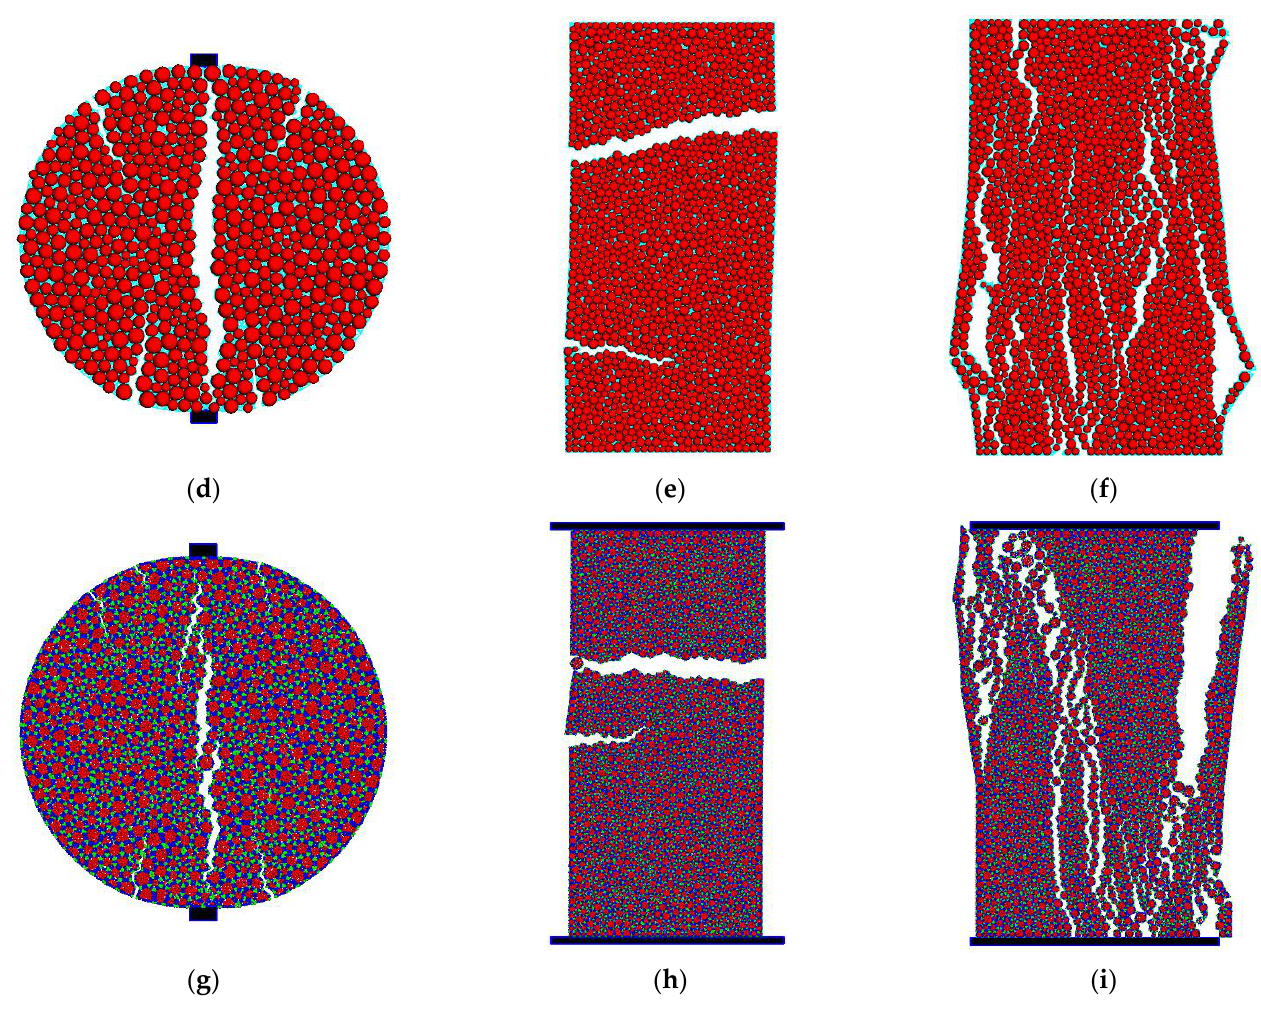
Figure 10. Particle assemblies: ( a ) Brazilian test (Rigid PM model); ( b ) uniaxial tensile test (Rigid PM model); ( c ) uniaxial compression test (Rigid PM model); ( d ) Brazilian test (proposed flexible PM model); ( e ) uniaxial tensile test (proposed flexible PM model); ( f ) uniaxial compression test (Proposed flexible PM model); ( g ) Brazilian test (DEM-Flexible); ( h ) uniaxial tensile test (DEM-Flexible) and ( i ) uniaxial compression test.